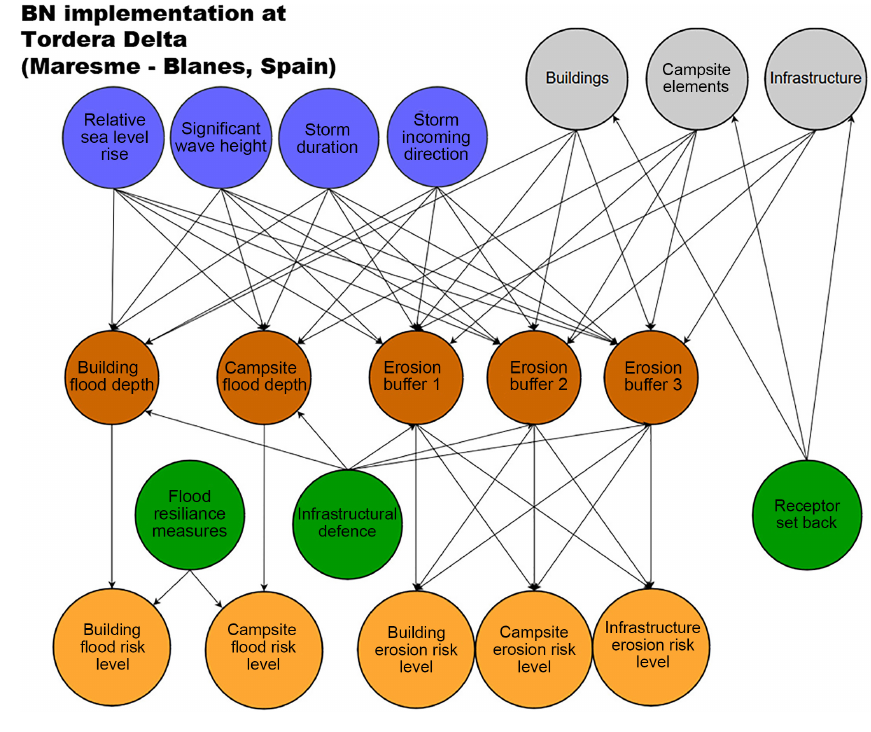
Figure 8. Bayesian network scheme for the Tordera Delta site.